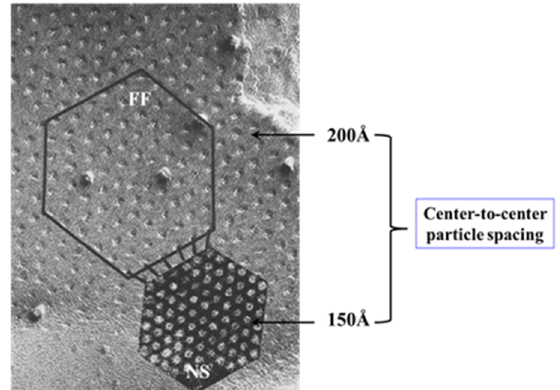
Figure 15. Gap junctions of crayfish lateral giant axons seen in freeze fracture (FF) and in negatively stained isolated junction fragment (NS). In gap junctions fixed in coupled conditions the channels are packed in loose arrays at ~200 Å center-to-center spacing (FF). In contrast, in isolated, negatively stained samples the channels are tightly packed in tight crystalline, hexagonal arrays at 150–170 Å center-to-center spacing (NS), as in axons exposed to treatments known to increase [Ca 2+ ] i (see Figure 13B). We interpreted these changes to reflect a switch from open- to closed-channel state. We believe that gap junction crystallization represents an irreversible “locked-gate” gating state. Adapted from ref. [128].